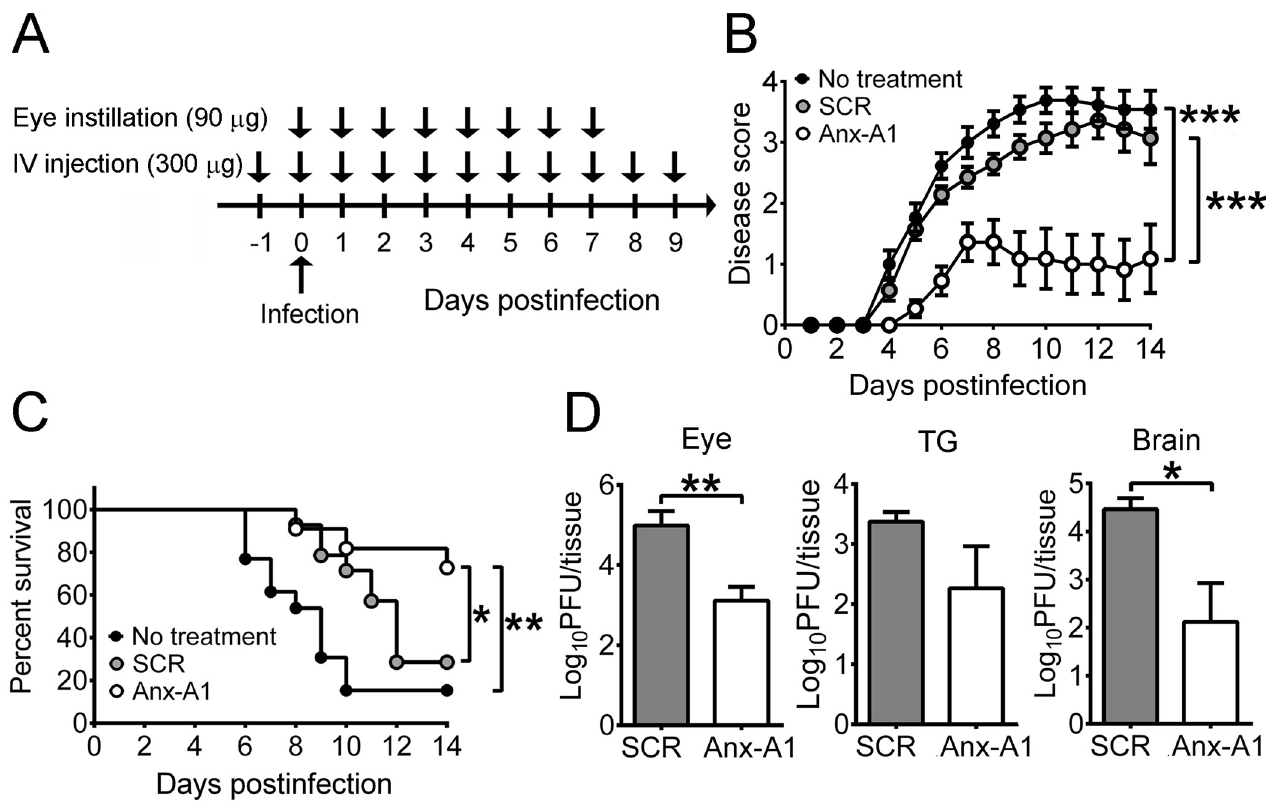
Fig 6. Suppression of Anx-A1 expression reduces the mortality and tissue viral loads of HSV-1-infected mice. ( A ) WT mice were treated without or with ODNs on the eye and by intravenous (IV) injection and infected with HSV-1 as indicated. The disease scores ( B ) and survival rates ( C ) of infected mice treated without ODN (No treatment; n = 13) or with scramble ODN (SCR; n = 14) or Anx-A1 antisense ODN ( n = 11) are shown. ( D ) Viral loads in the indicated tissues of mice treated with scramble (SCR; n = 6/group) or Anx-A1 antisense ODN ( n = 7/group) were determined at 7 dpi. Data show the mean + SEM in panels B and D. � P < 0.05, �� P < 0.01, and ��� P <